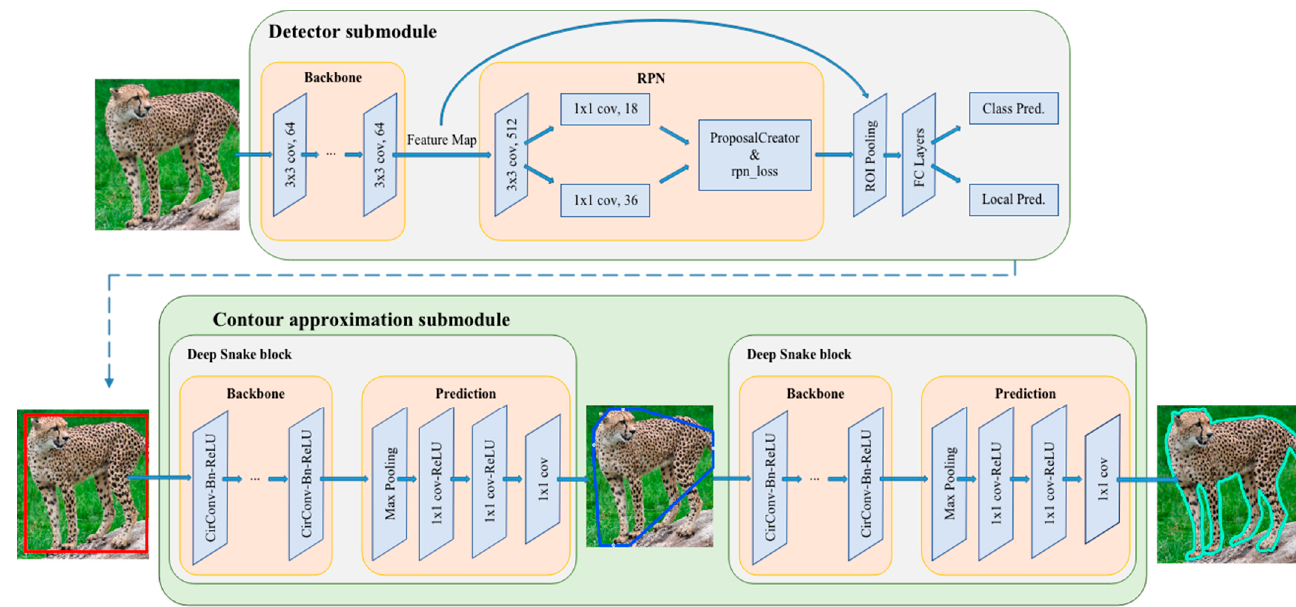
Figure 3. Overall illustration of the proposed two-stage wildlife instance segmentation method. The detector submodule contains the backbone ResNet101, followed by the region proposal network (RPN), and fully connected (FC) layers propose object categories and bounding box localization. The contour approximation submodule consists of two deep snake blocks. The first deep snake block turns the rectangular box generated by the detector submodule into the octagon contour, and the second deep snake block takes the octagon contour as the input to approximate the contour of the animal shape.